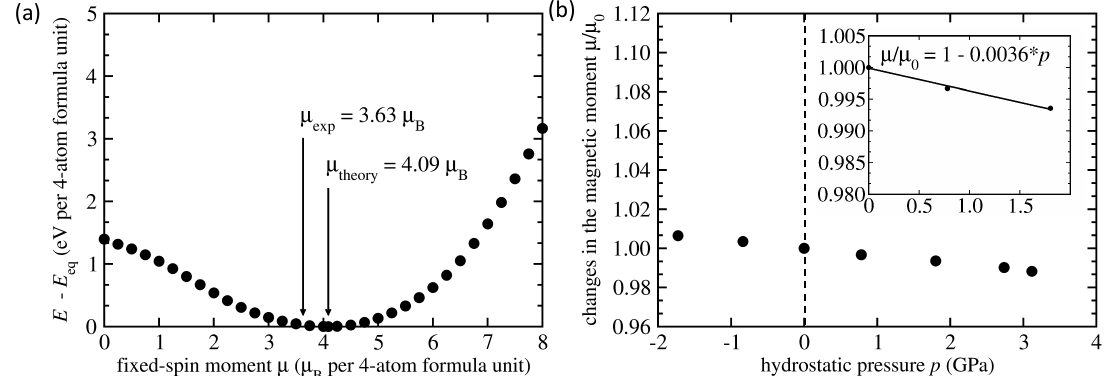
Figure 2. Computed total energy difference of the austenitic stoichiometric Ni 2 MnSn with different values of the fixed total magnetic moment with respect to the energy of the ground state ( a ). Arrows indicate experimental value of the magnetic moment and the theoretical value corresponding to the minimum of the energy. Part ( b ) shows calculated pressure-induced changes of the total magnetic moment µ relative to its zero-pressure value µ 0 . The inset contains a linear fit through the values in the lower-pressure region and its parameters including the value of d(ln µ ) /d p close to the zero-pressure magnetic moment µ 0 approximated as ( 1/ µ 0 ) d µ /d p = d ( µ / µ 0 ) /d p = − 0.0036 GPa − 1